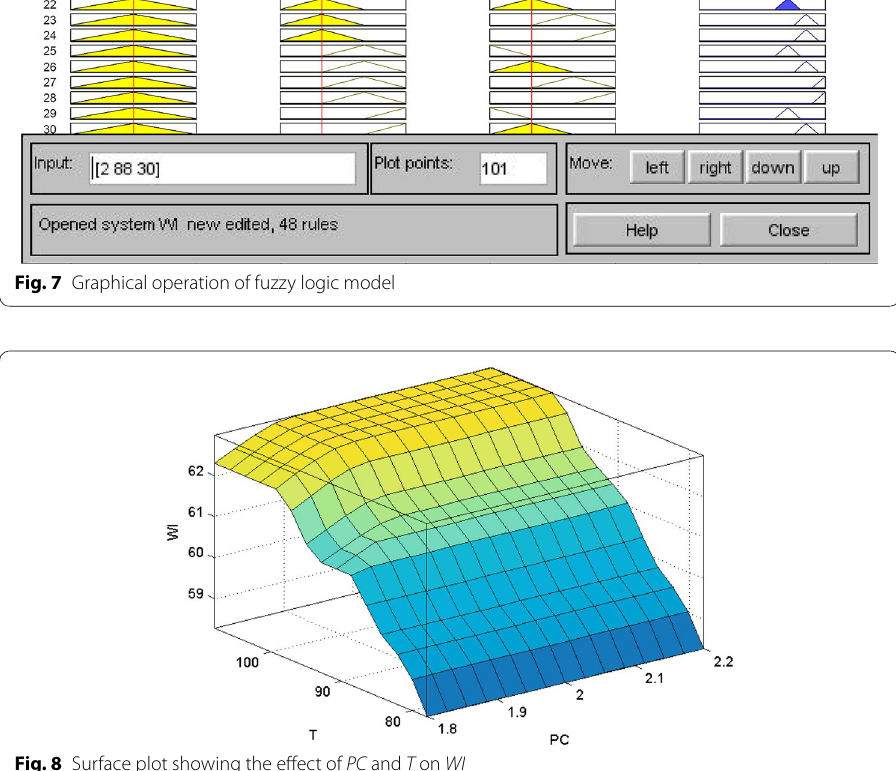
Fig. 8 Surface plot showing the effect of PC and T on